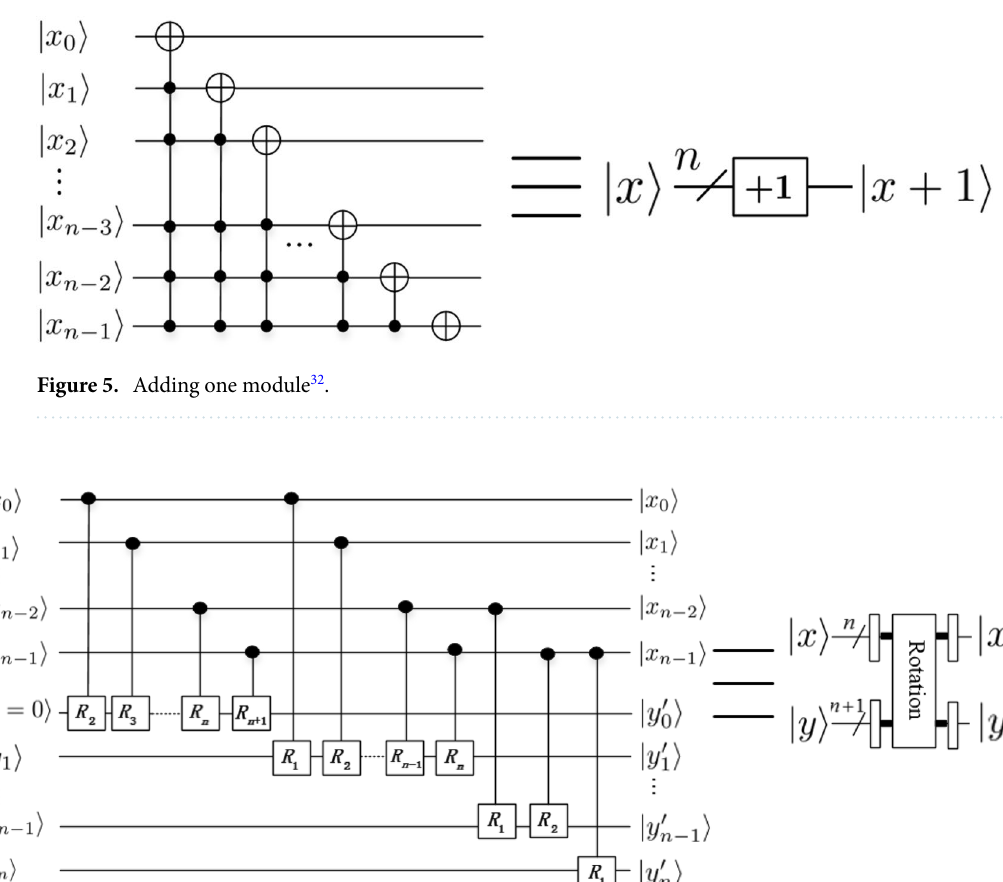
Figure 6. Rotation module 31